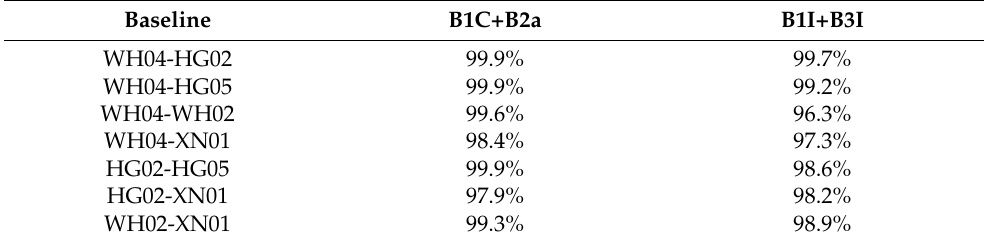
Table 4. The fixed success rate of the baselines in reference networks.